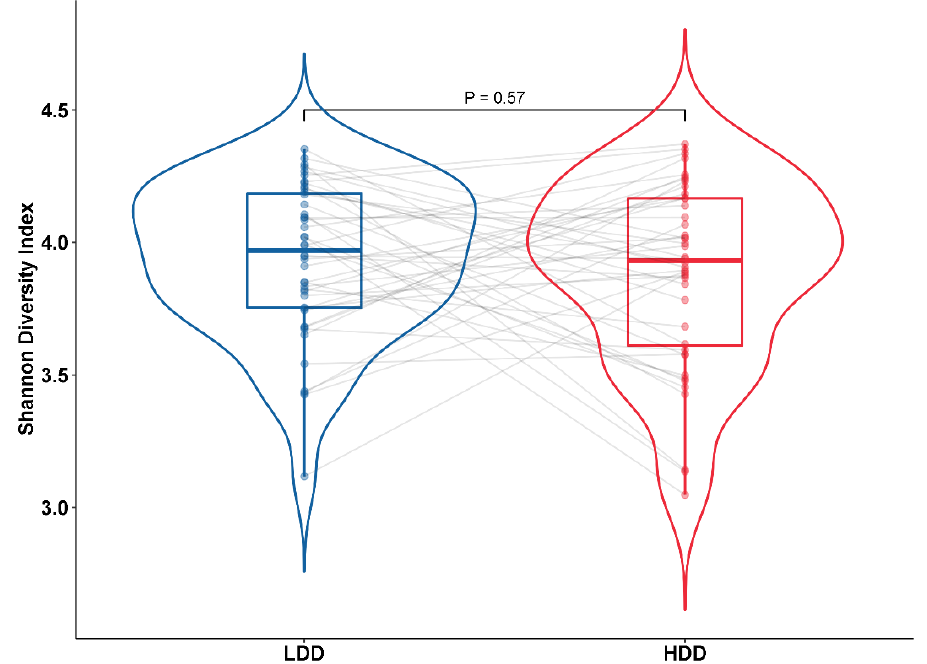
Figure 2. This figure depicts the Shannon diversity of the gut microbiome during the LDD and the HDD. The lines represent the intra-individual link of participants. The Shannon diversity index was not significantly different between the HDD and the LDD (paired samples Wilcoxon test, p = 0.57).